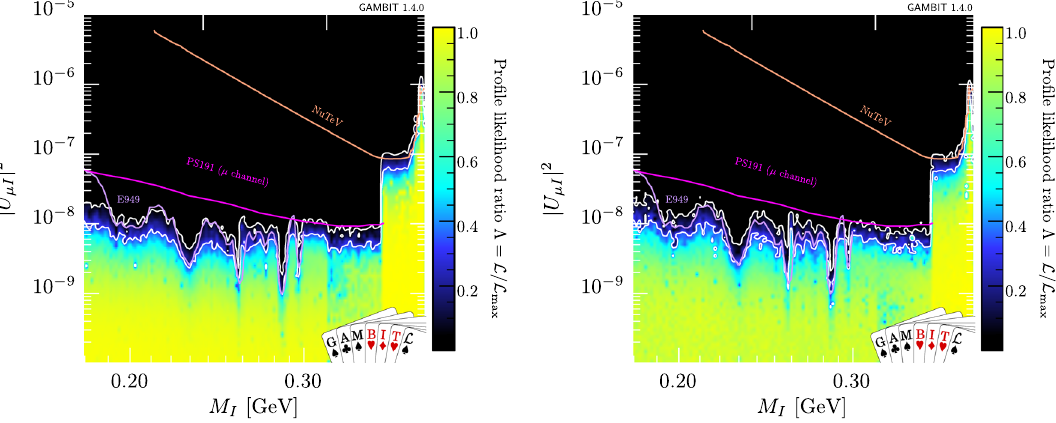
Fig. 10 Profilelikelihoodin M I vs U 2 μ planewith M I < 0 . I